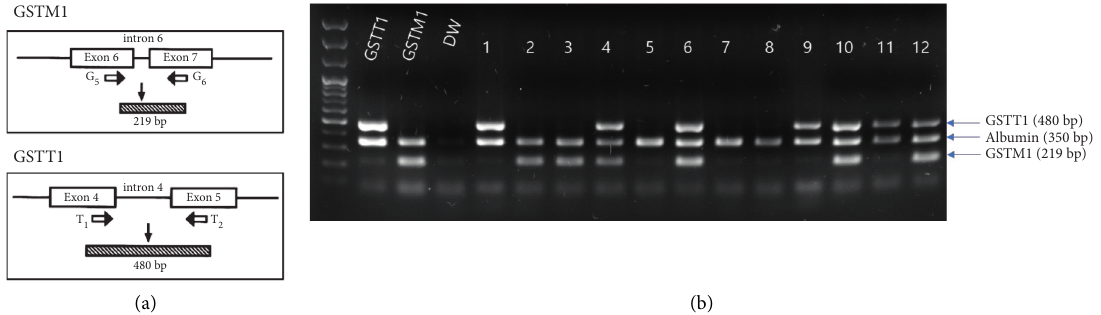
Figure 1: Primer positions (a) and gel electrophoresis of GSTM1 and GSTT1 RT-PCR products and albumin (b). Lanes 1, 9, and 11: GSTT1 wild/ GSTM1 null genotype; lanes 5, 7, and 8: GSTT1 / GSTM1 null genotype; lanes 4, 6, 10, and 12: GSTT1 / GSTM1 wild genotype; and lanes 2 and 3, GSTT1 null/ GSTM1 wild